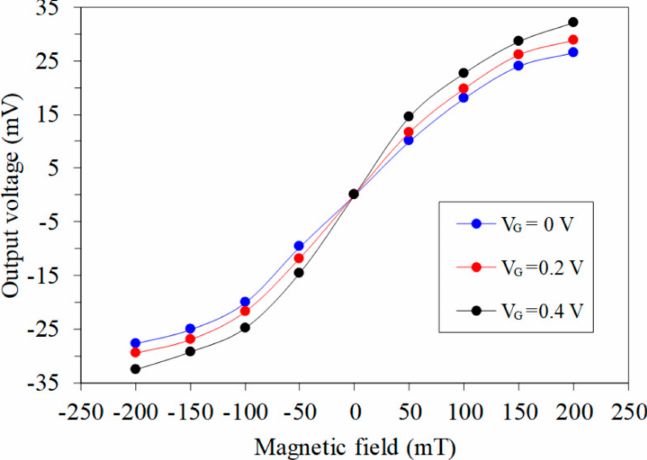
Figure 9. Tested OV in the y -axis magnetic field.